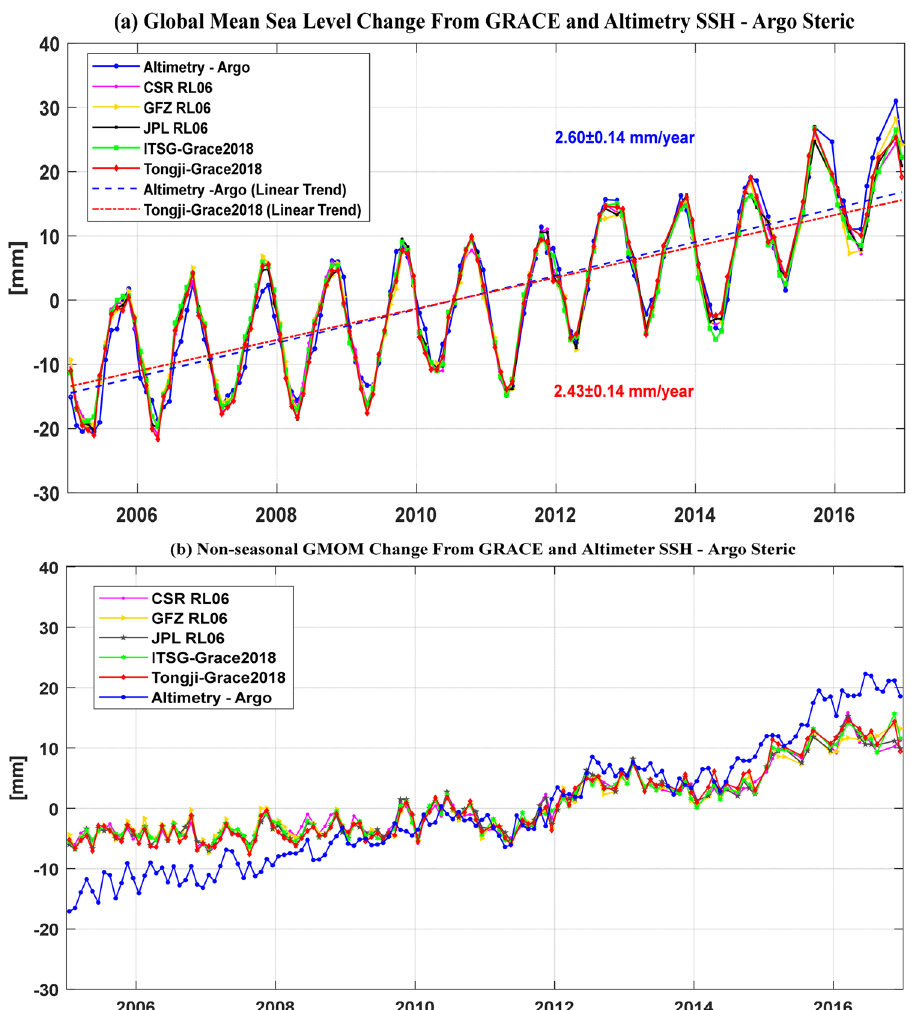
derived from GRACE and Altimetry–Argo.